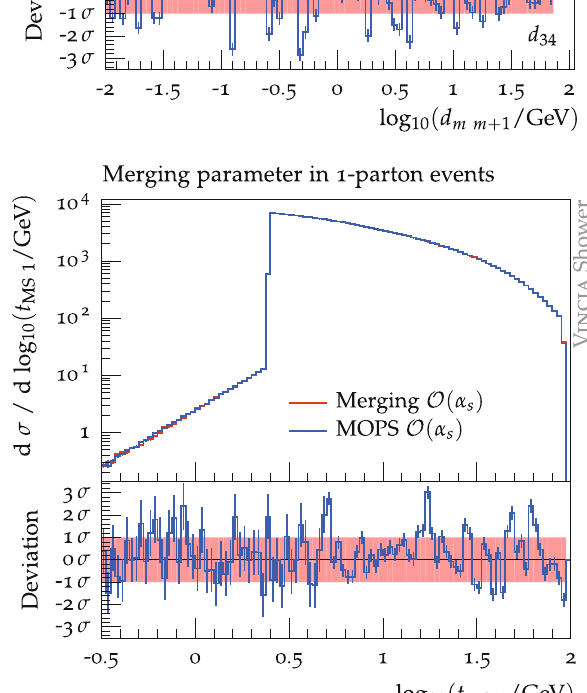
Fig. 8 Parton-level results for e + e − → Z → q ¯ qgg : the distribu- tion of the merging scale in exclusive 4-parton events ( bottom ) and the logarithmic distributions of differential jet resolutions. Comparison of MadGraph 4, MadGraph 5, and Vincia +MadGraph 4+Rambo ordered sequence of branching scales. To ensure the same Sudakov factors ME corrections are also applied in the case of